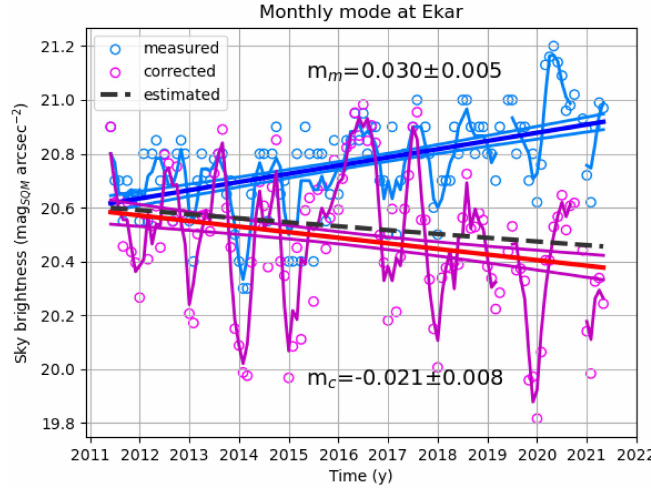
Figure 14. Monthly modal value of night sky brightness at Ekar. In blue the measured values, their average trend and linear fitting, in magenta the corrected values and their fitting in red; m is the slope of the fitting lines in mag SQM arcsec − 2 year − 1 . In dashed grey line is the expected trend due to increase on installed outdoor luminous